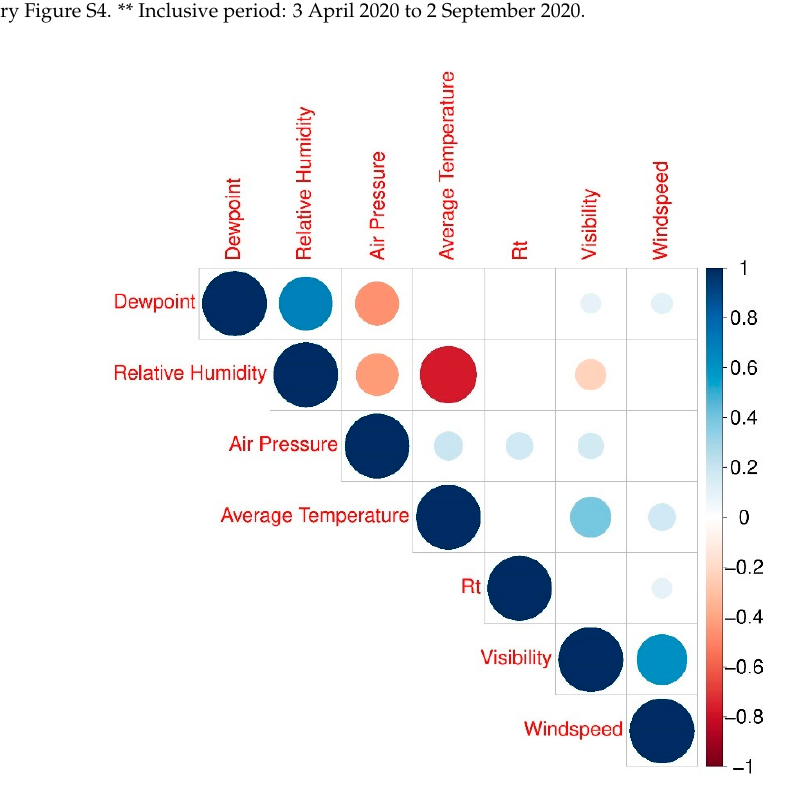
Figure 1. Matrix of correlation coefficients of exposure variables and R t . Statistically significant associations are shown in gradient colors. Positive correla- tions are represented with blue gradient, whereas negative associations are shown in red gradient. The darker the colors, the higher the correlation coefficient. Not significant cor- relations are depicted with blank spaces.